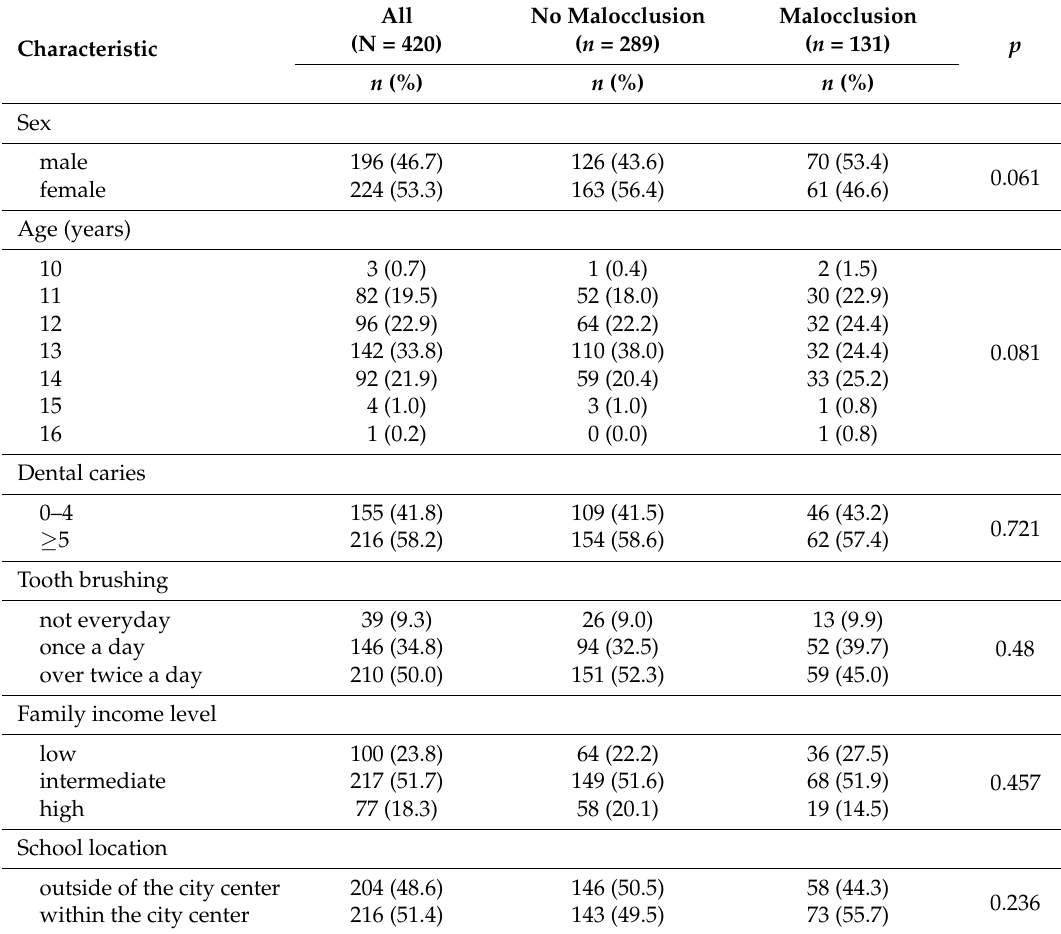
Table 1. Demographic characteristics of the study